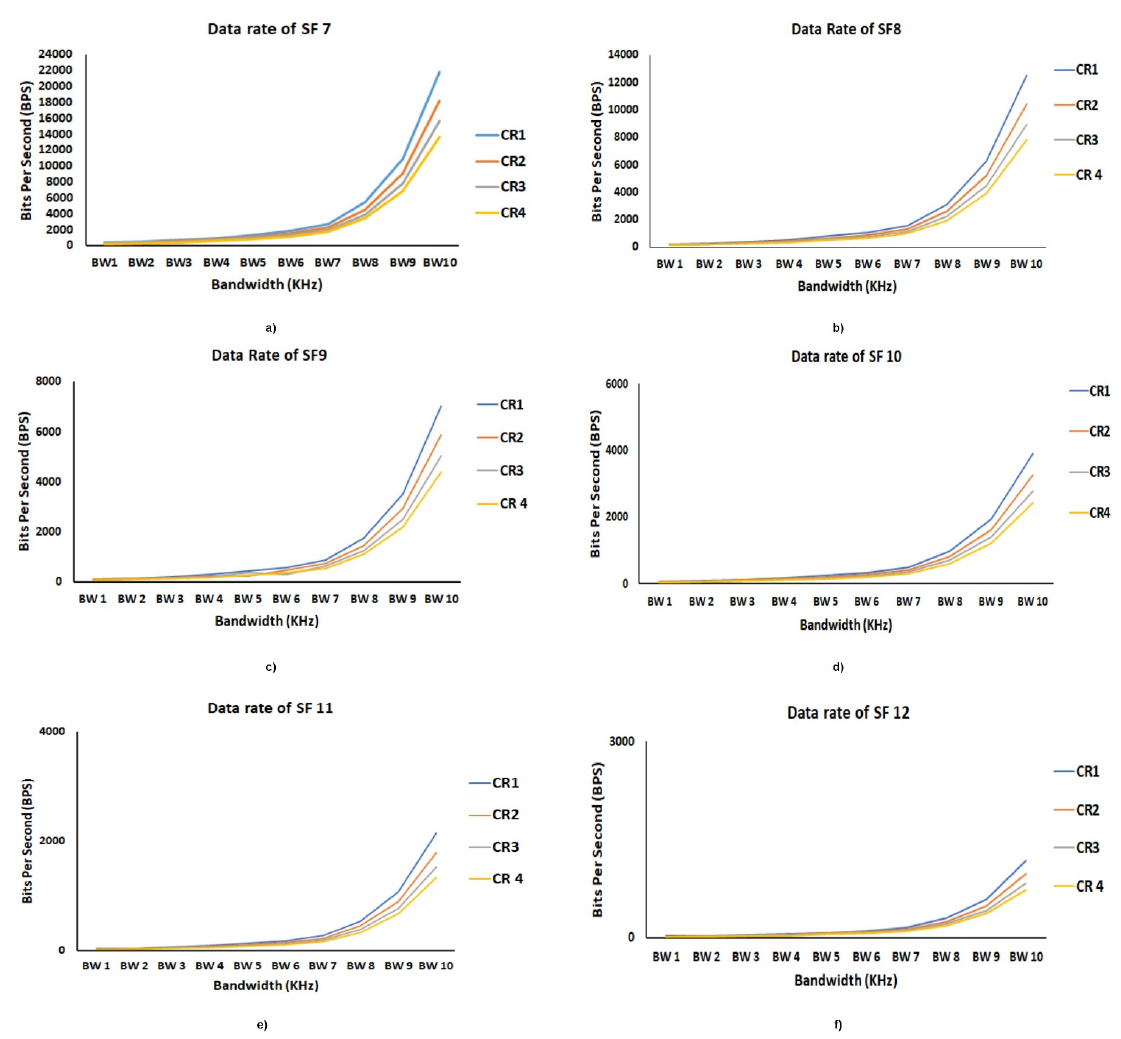
Figure 15. Data rate of LoRa from SF 7 to SF 12.